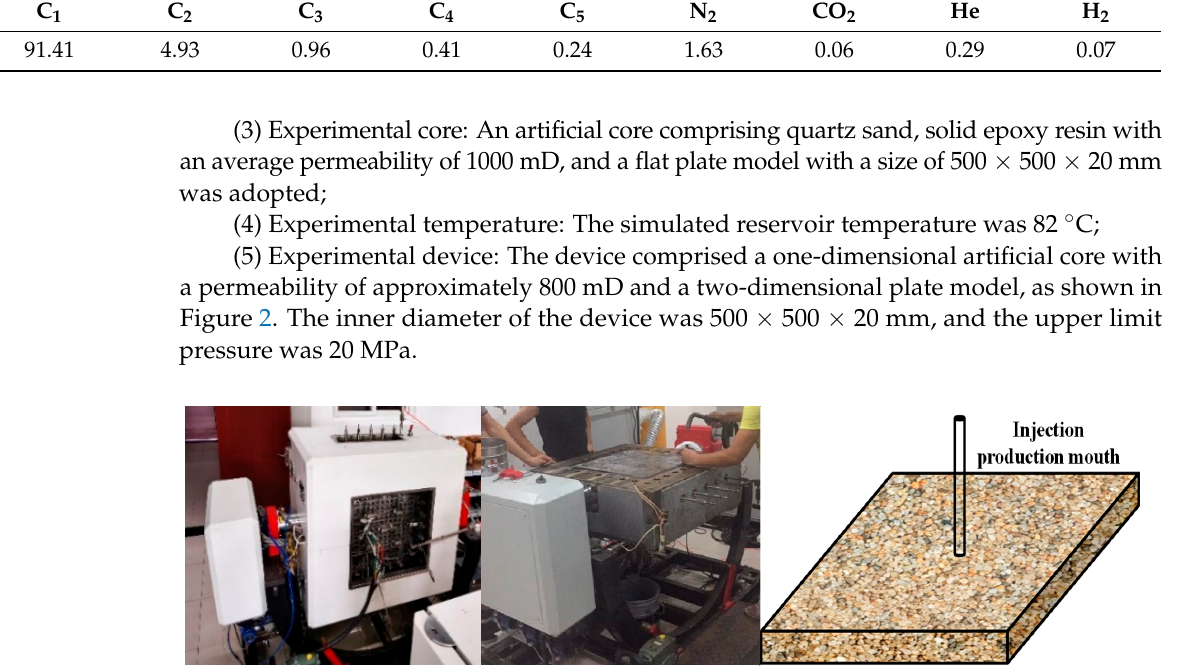
Figure 2. Two-dimensional core simulation setup: ( left ) overall appearance; ( middle ) plate placement, ( right ) schematic diagram of the injection and mining method.